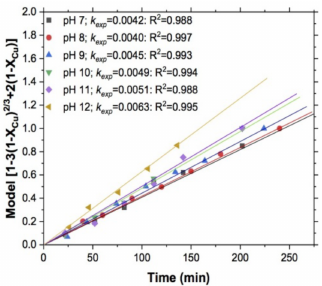
Figure 12. Effect of pH. Reaction order, n = 0.699. Experimental conditions: T = 318 K,